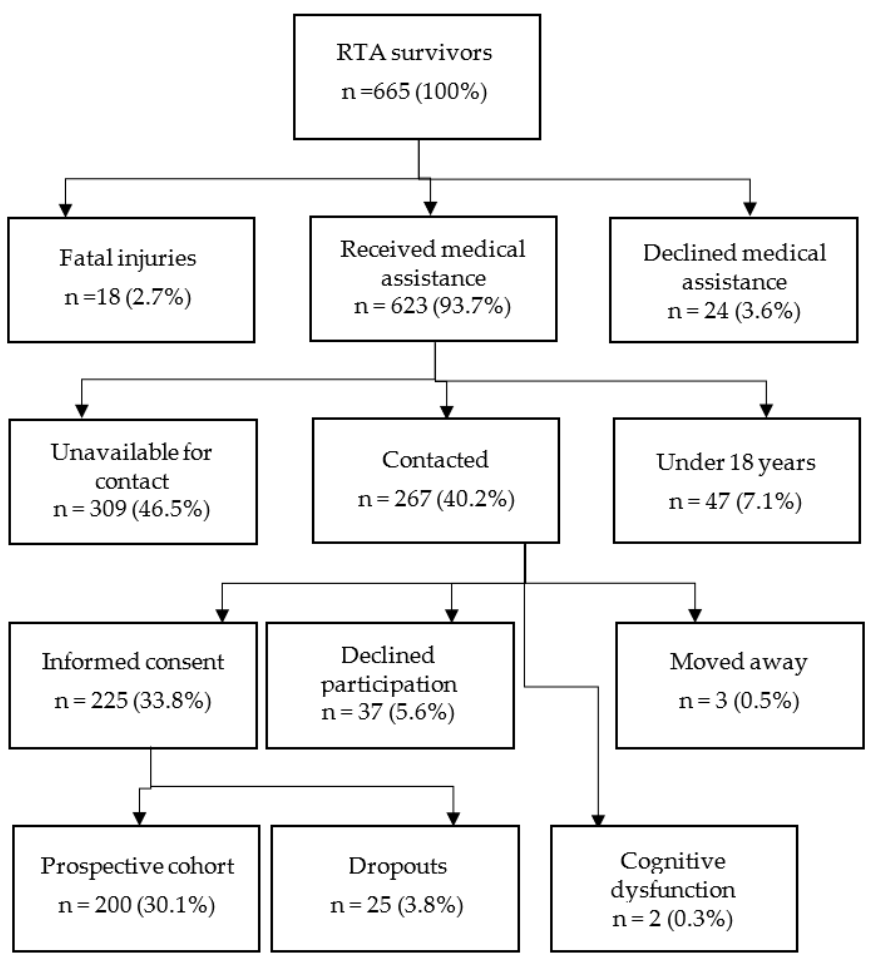
Figure 1. Participant recruitment process.